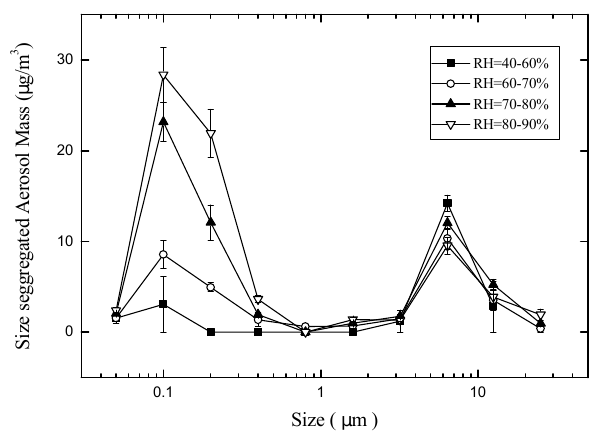
Fig. 11. Size segregated surface aerosol mass distribution obtained with a QCM system for different surface humidity conditions in the ten cut-off size ranges of the